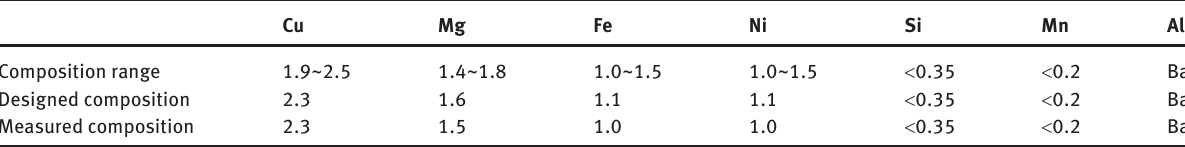
Table 1: Chemical compositions of experimental alloys (mass fraction, %). Cu Mg Fe